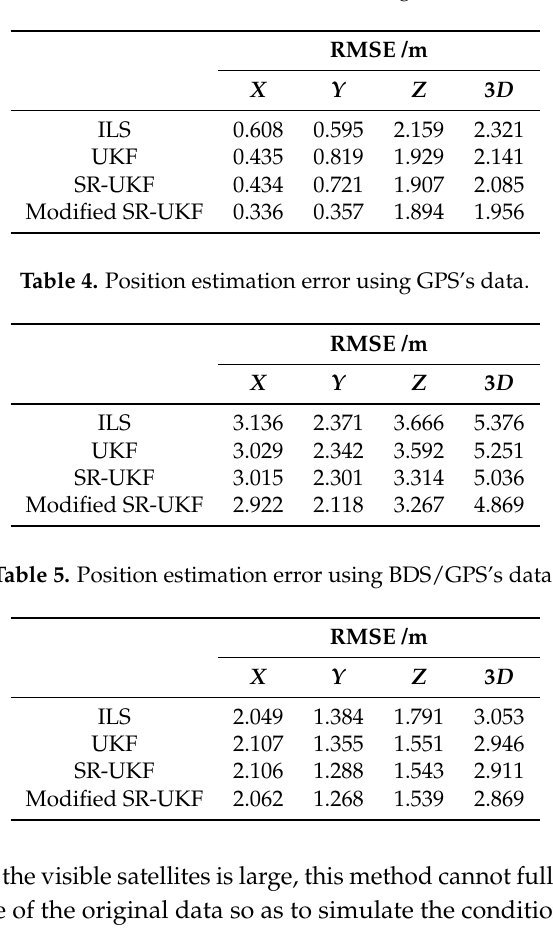
Figure 5. Position estimation error using BDS/GPS’s data. Table 3. Position estimation error using BDS’s data.